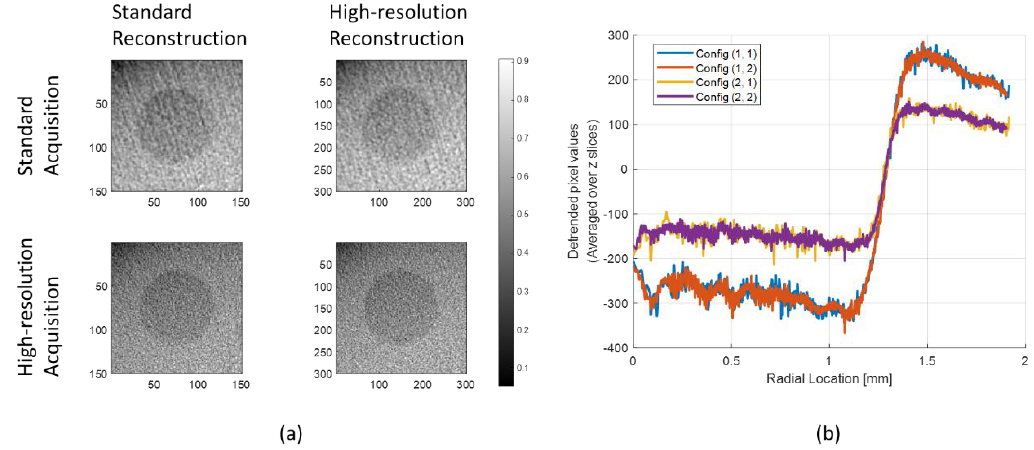
Figure 7. ( a ) Reconstructed image with different configurations using the Hanning window and ( b ) the radial profile of each configuration.